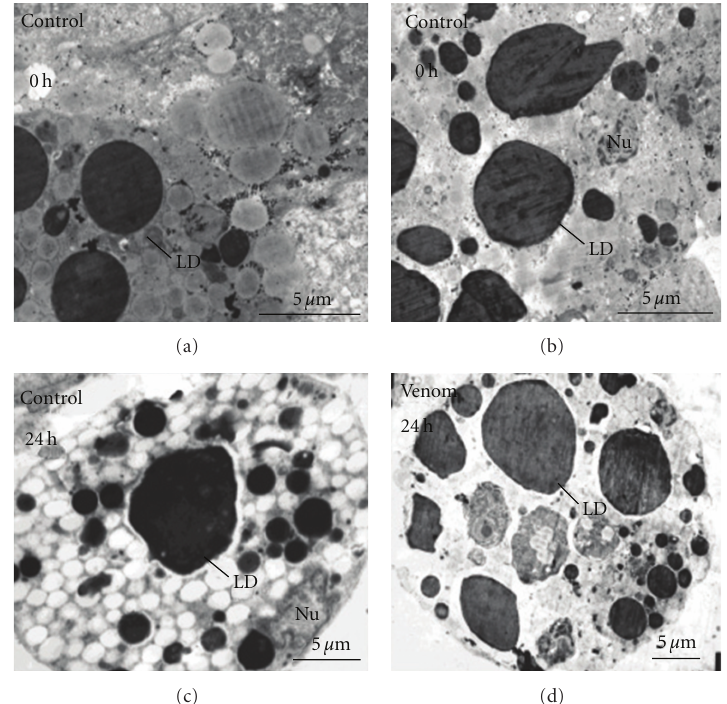
Figure 5: Ultrastructure of fat body from young pharate adults of S. bullata following envenomation by N . vitripennis . At 0 h, numerous lipid droplets (LD) of varying sizes and densities were evident throughout the cytoplasm. Large, prominent nuclei (Nu) were also typical of fat body cells. By 24h posttreatment, fat body cells from controls and envenomated hosts appeared nearly identical: numerous lipid droplets were present, yet few inclusions appeared in the cytoplasm of either cell